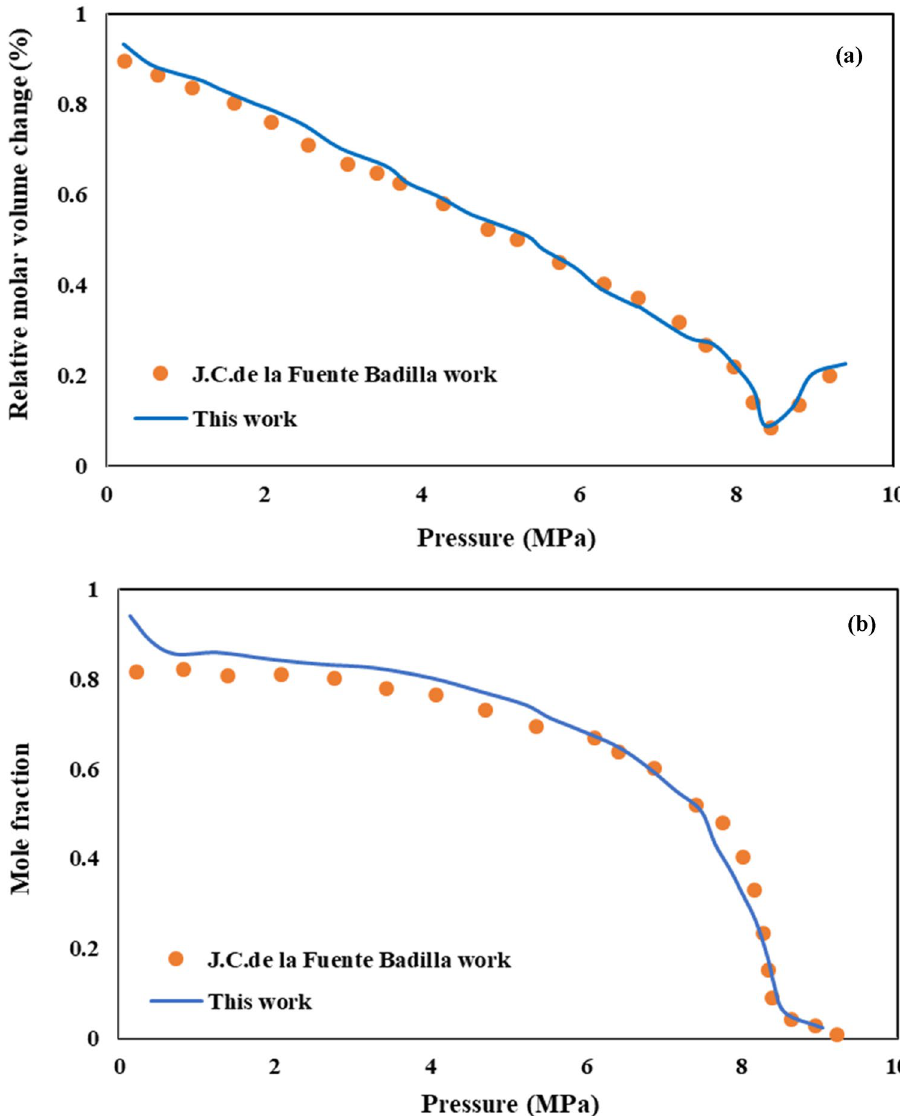
Figure 5. Comparison the results of model and experimental data for CO 2 – toluene–naphthalene ternary system (a) relative change in molar volume, (b) variation of solute (naphthalene) mole